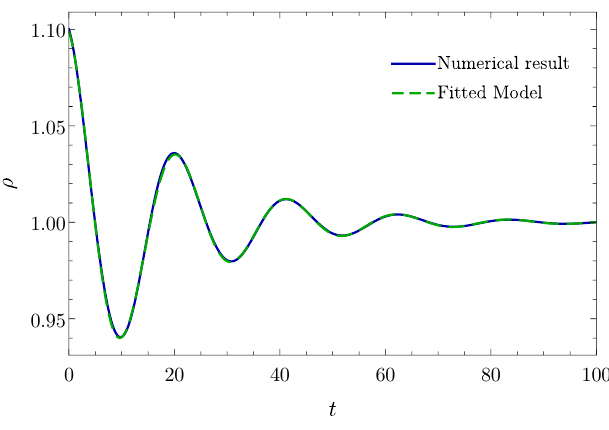
Figure 15 . Time dependence of the mass density ρ at the origin, for a sound mode perturbation with k = 0 . 3 and q = 0 . 7 , together with the fitted model of the form 0 /ρ 0